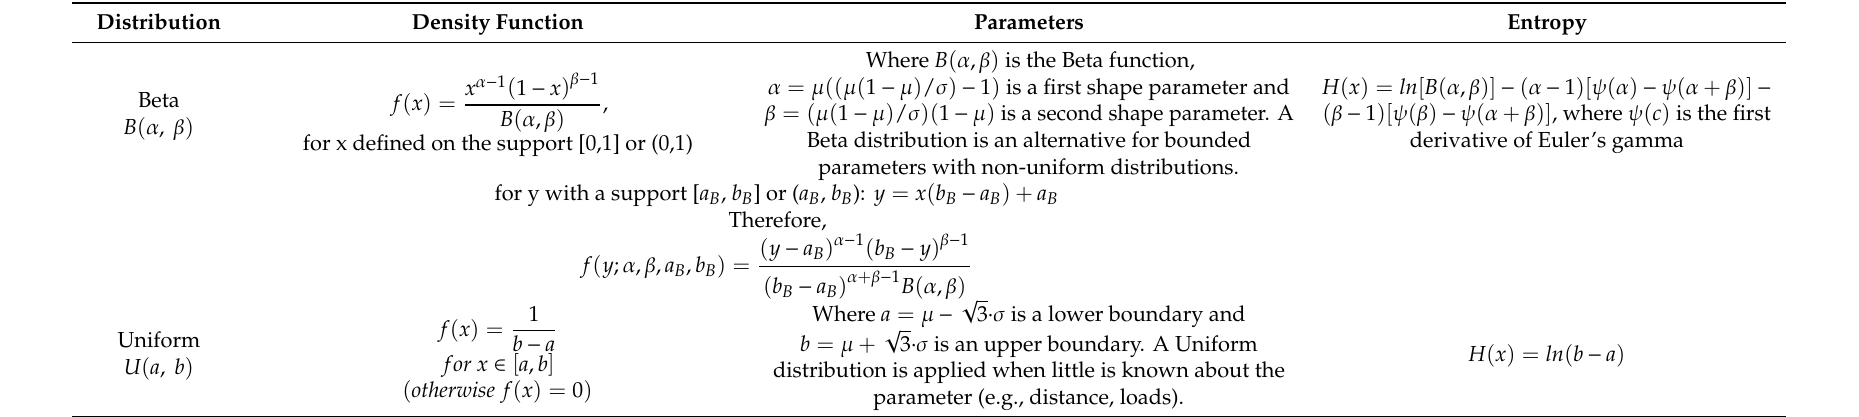
Table 4. Probability distributions used to build marginal distributions for the model input